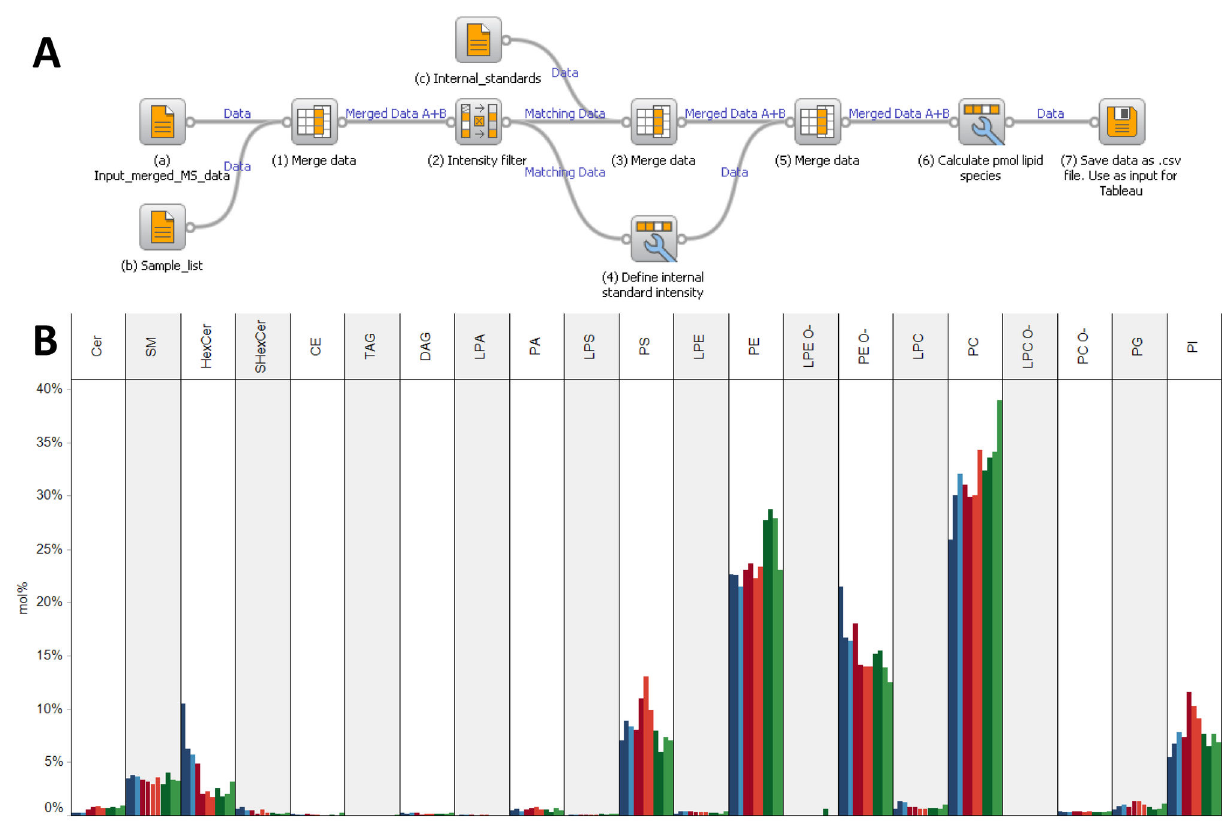
Figure 5. Outline of the auxiliary workflow used for lipidome data processing. ( A ) A sequence of processing steps executed by the Orange software is used to compute the molar abundance of lipid species. The processing routine utilizes three input files: (a) the output file generated by the ALEX framework specifying lipid intensities, (b) a text file specifying sample information, and (c) a text file specifying internal standards and molar spike amounts. Seven processing steps are executed in order to compute the molar abundances of lipid species for all samples. The data processing generates an output file in database table format featuring the molar abundances of lipid species, originating intensity data, all accessory lipid features and all sample information. ( B ) Lipid class composition of cerebellum, hippocampus and S1BF from wild-type and PRG-1 knockout mice as automatically calculated and displayed using Tableau